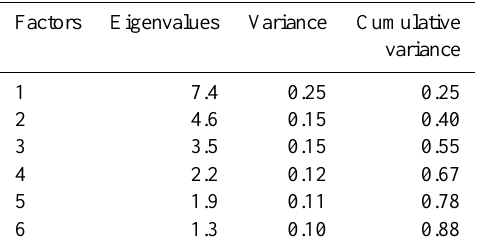
Table 8. Eigenvalue, variance an cumulative variance explained by factor analysis in subsoil samples ( n =